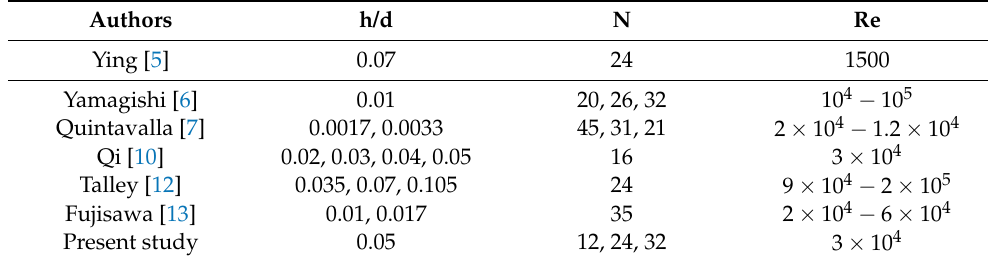
Table 1. Geometry of grooved circular